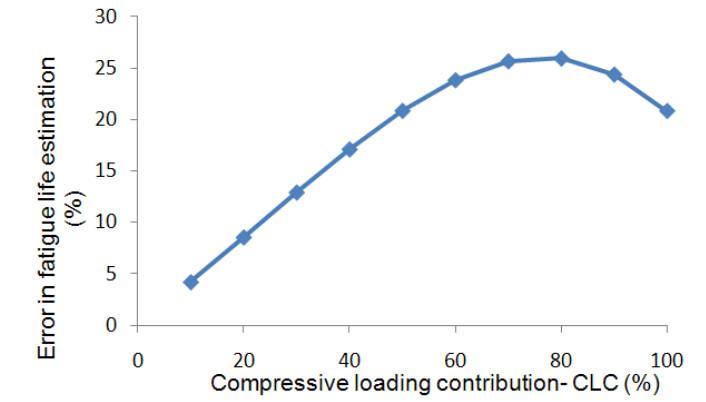
Figure 38. Fatigue life calculation’s error as a function of